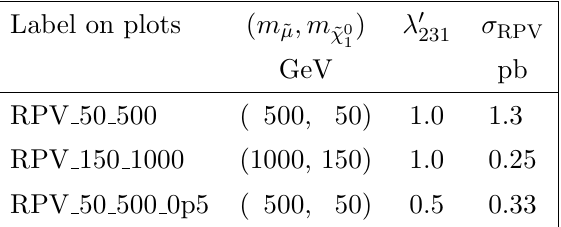
Table 1. The example RPV SUSY models used in this